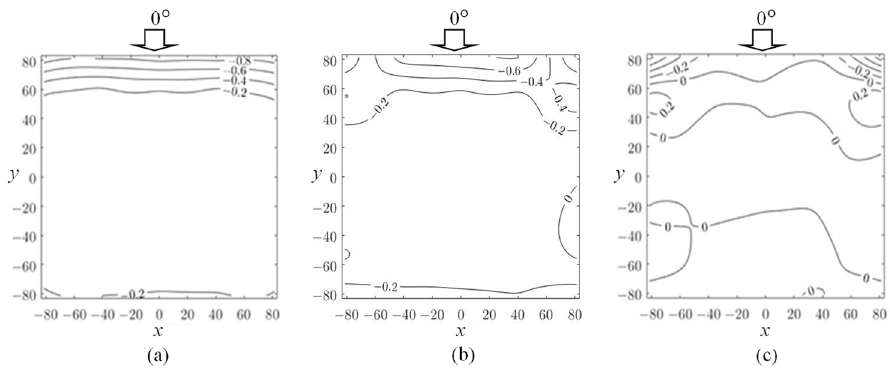
Figure 5. Contours of mean wind pressure and force coefficients at θ = 0 ◦ : ( a ) C pt , ( b ) C pb , ( c ) C f